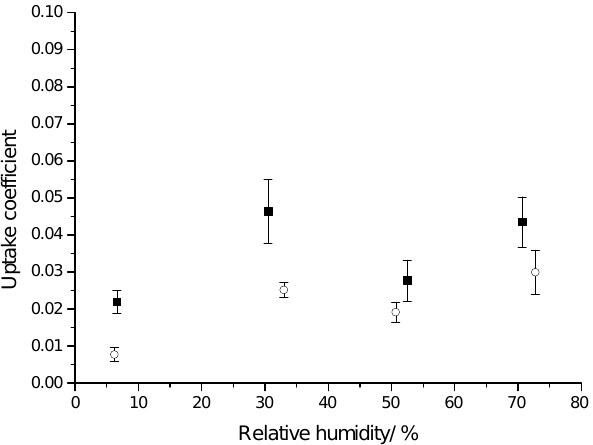
Figure 6. HO 2 uptake coefficients onto ATD aerosols measured at different relative humidities and at an initial HO 2 concentration of 1 × 10 9 molecule cm -3 (open symbols) and 3 × 10 8 molecule cm -3 (closed symbols). The error bars represent one standard deviation of the average of a number of repeated experiments.